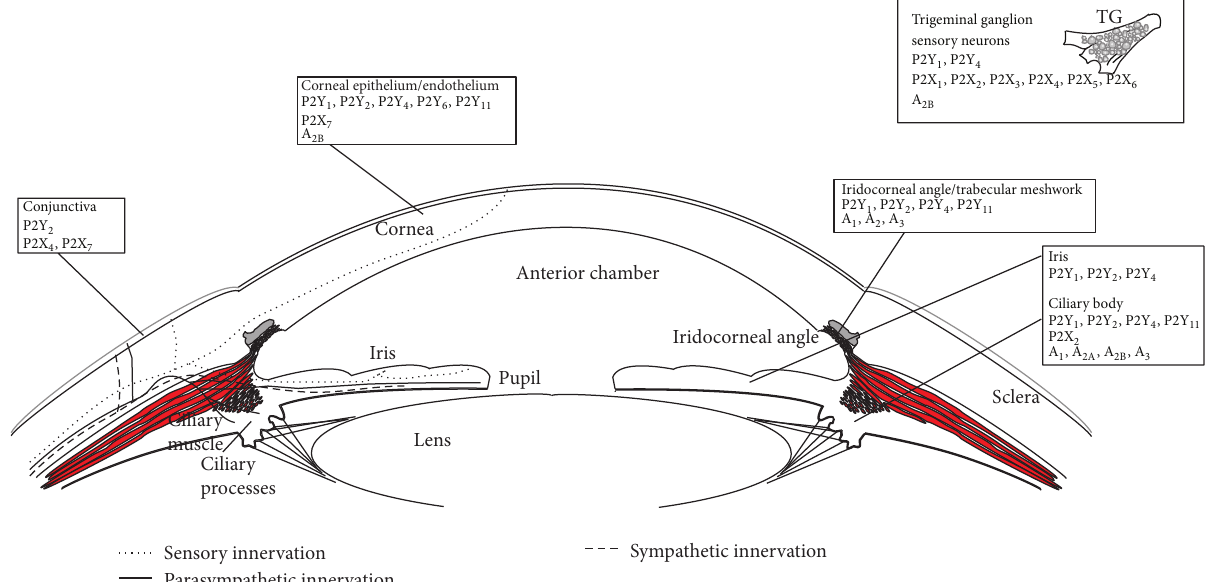
Figure 1: Purinergic receptors identified in the ocular anterior segment. Purinergic receptors localized in the different ocular parts/structures of the ocular anterior segment are